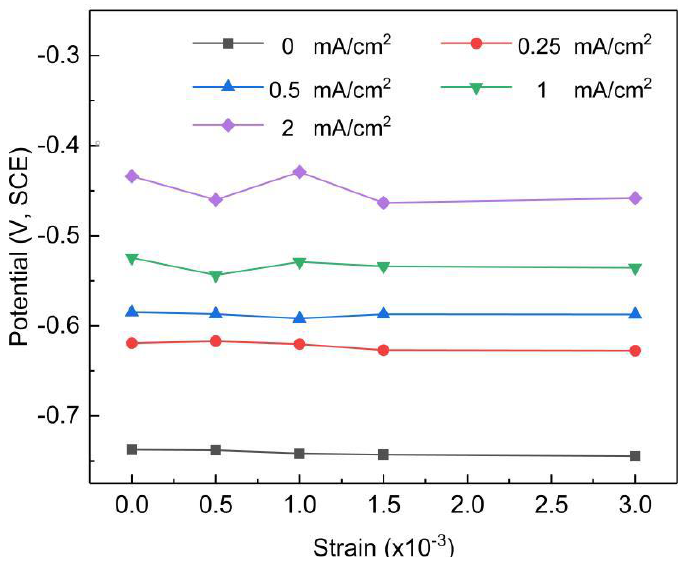
Figure 4. The potential variations in X80 steel samples in the NS4 solution with different strains at various DC densities.